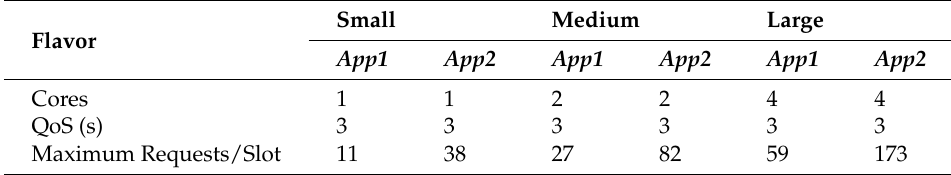
Table 3. Identified VM Flavors.